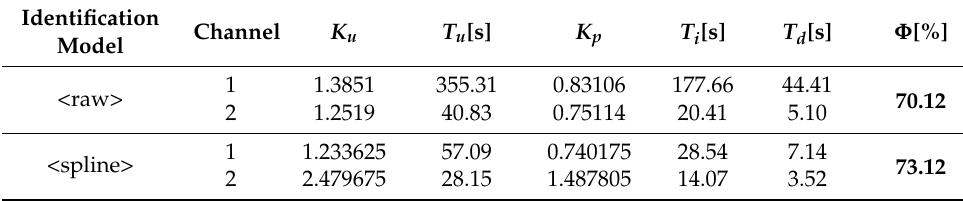
Table 3. Parameters of PID-R controllers tuned by the Ziegler–Nichols